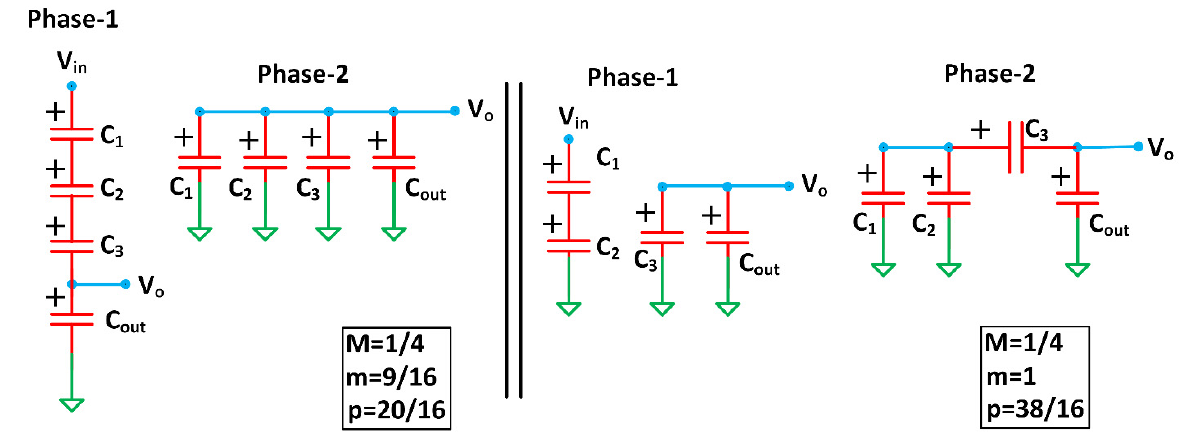
Figure 2. Example of two circuit topologies of SCPCs with M = 0.25 exhibiting different output impedances with three floating capacitors [21]. Reproduced from [21], In Proceedings of the IEEE Power Electronics Specialists Conference: 1995.